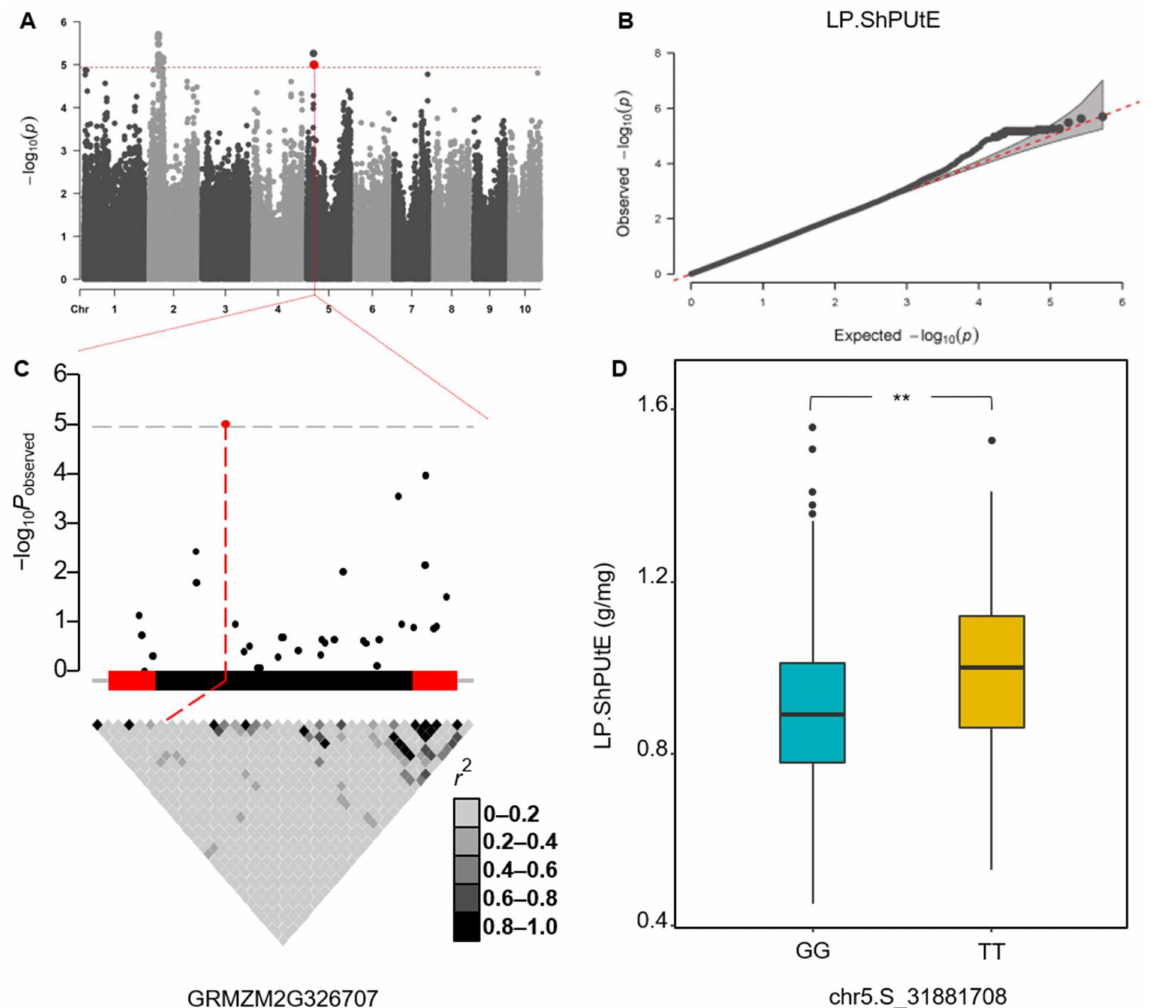
Figure 4. Manhattan ( A ) and quantile–quantile ( B ) plot for ShPUtE under low-P condition; gene structure of GR- MZM2G326707 and pairwise linkage disequilibrium (LD) analysis ( C ); and the distribution of two genotypes for ShPUtE under the low-P condition in our population ( t -test, p < 0.01) ( D ). The dotted line is the significance threshold of 4.94. ShPUtE: Shoot P utilization efficiency. **: Significant at 0.01